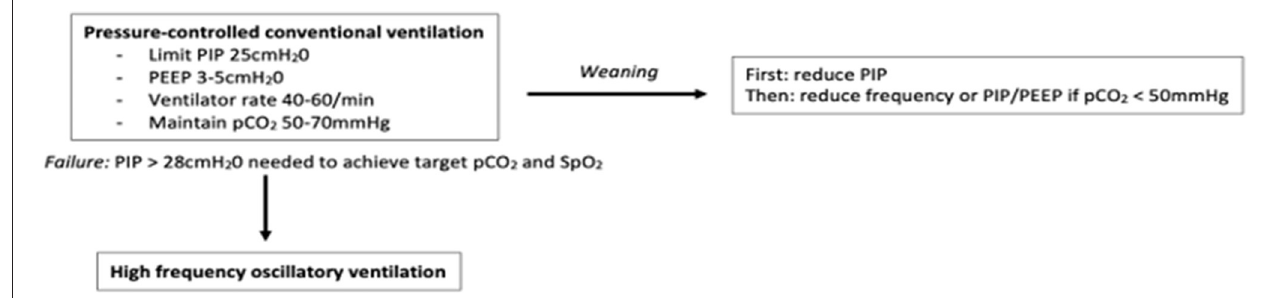
FIGURE 2 | Flow diagram of initial ventilatory